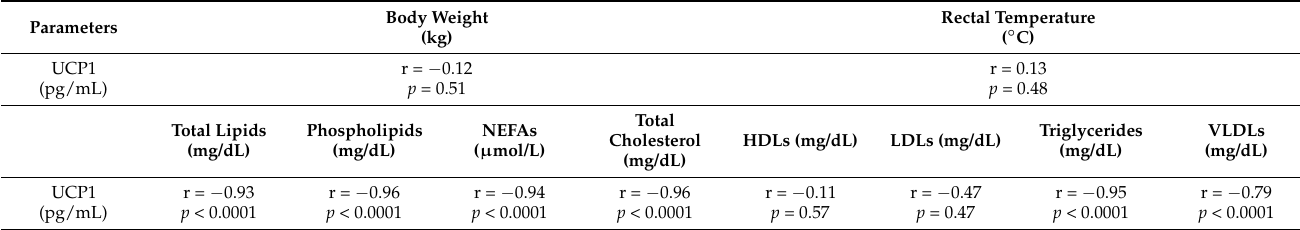
Table 1. Results of correlation analysis (r Pearson; p value) between the levels of serum mitochondrial uncoupling protein-1 (UCP1) and the values of body weight, rectal temperature, total lipids, phospholipids, non-esterified fatty acids (NEFAs), total cholesterol, high density lipoproteins (HDLs), low density lipoproteins (LDLs) triglycerides and very low density lipoproteins (VLDLs) values calculated for horses enrolled in the study. p values < 0.05 were considered statistically